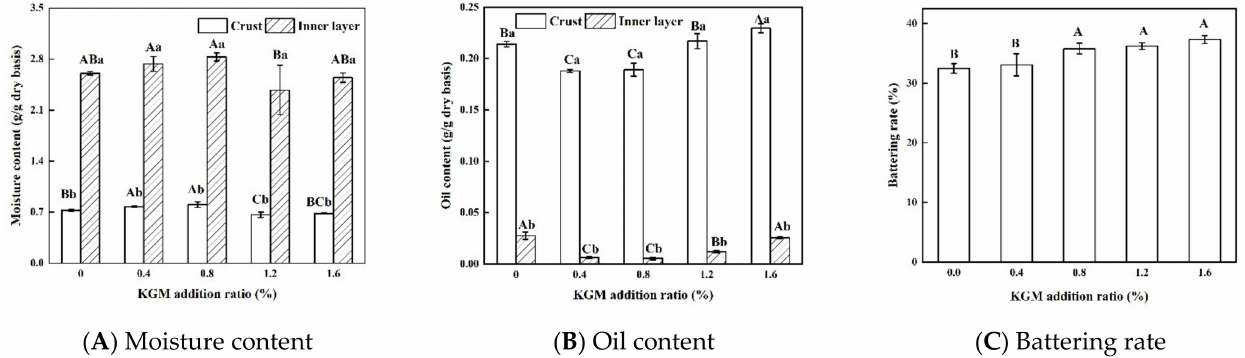
Figure 1. Moisture content ( A ), oil content ( B ), and battering rate ( C ) of fried battered fish nuggets with different proportions of KGM. Note: Different capital letters indicate that there are significant differences between different conditions ( p < 0.05). Different lowercase letters indicate that there are significant differences between the crust and the inner layer in the same condition ( p <